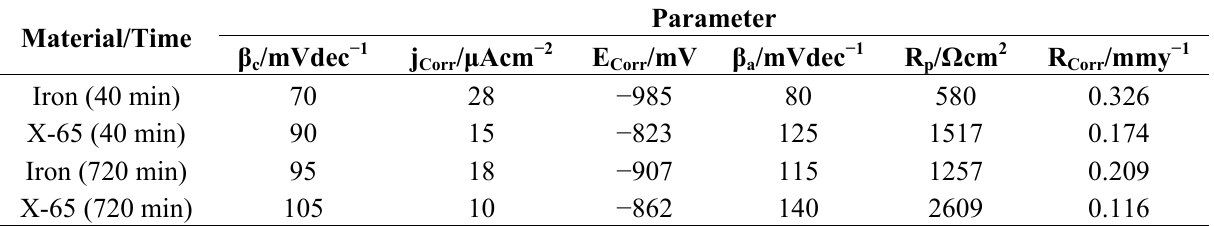
Table 1. Parameters obtained from potentiodynamic polarization curves shown in Figures 2 and 3 for iron and API X-65 steel after 40 min and 12 h immersion in 4.0 wt % NaCl